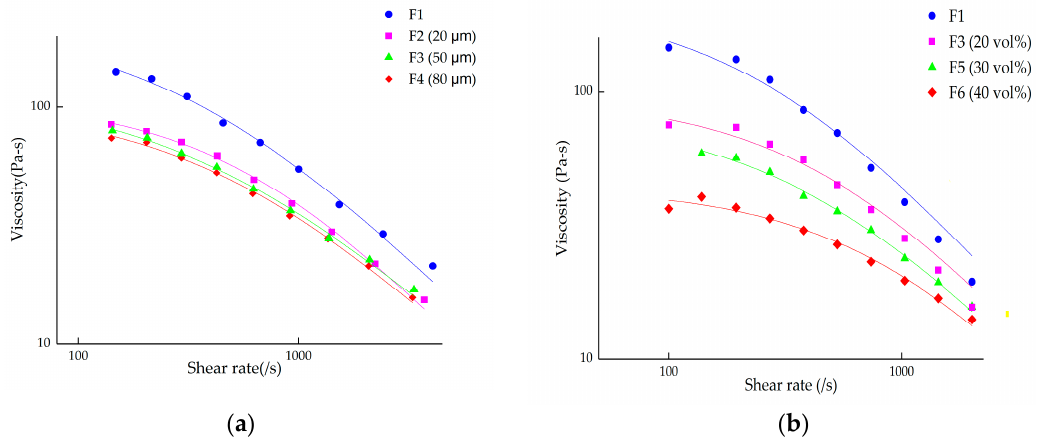
Figure 4. ( a ) Viscosity vs. shear rate results of F1, F2, F3, F4; and ( b ) viscosity vs. shear rate results of F1, F3, F5, F6.